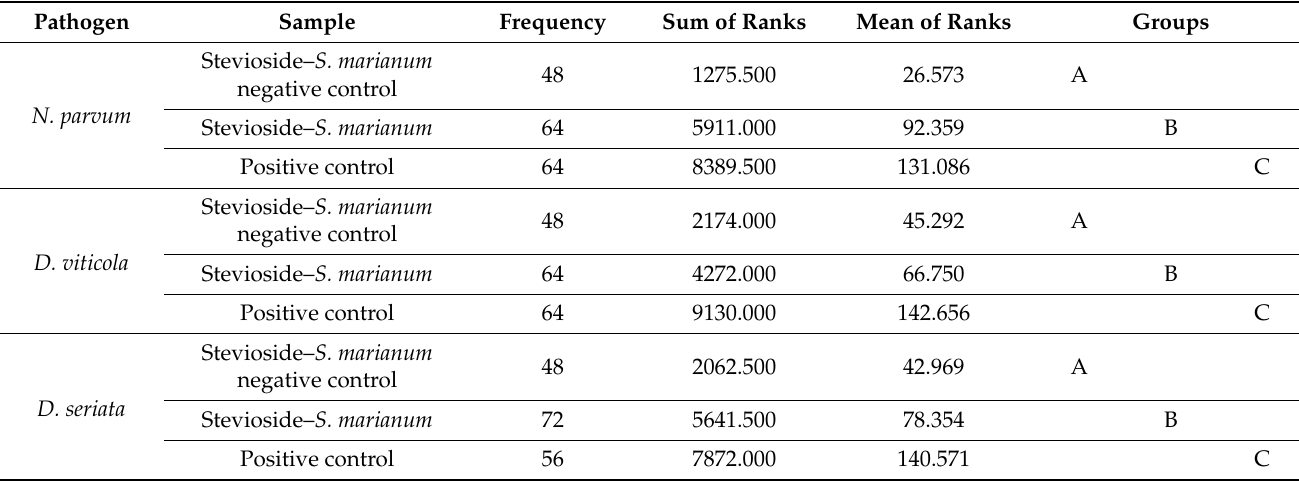
Table 6. Kruskal–Wallis test and multiple pairwise comparisons using the Conover–Iman procedure for the lengths of the vascular necroses for the three phytopathogen in greenhouse in vivo assays.